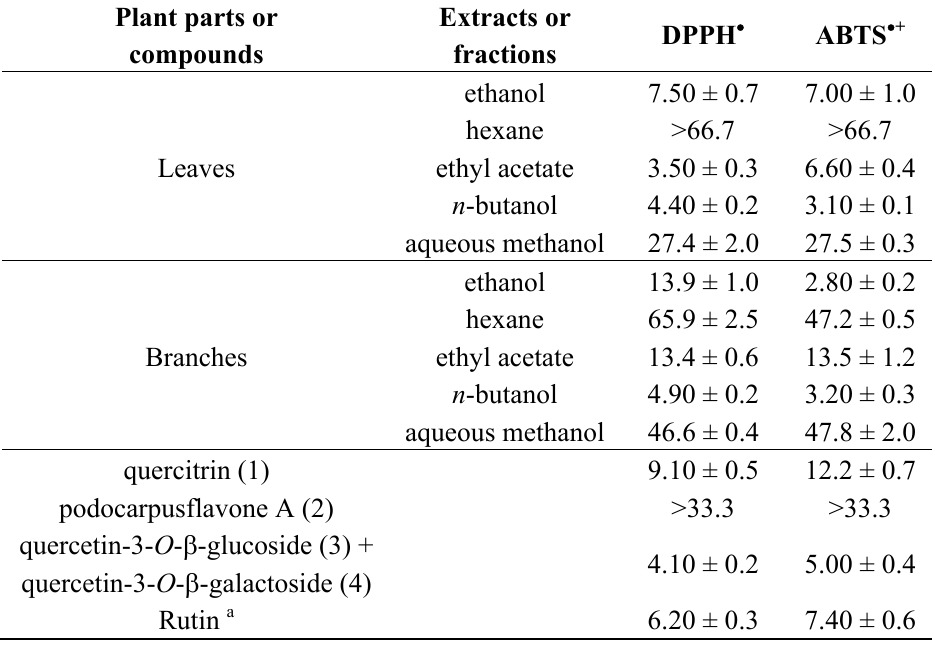
Table 1. Results of the scavenging effect of Kielmeyera variabilis on DPPH  and ABTS  + radicals expressed as IC ( μ g mL –1 50